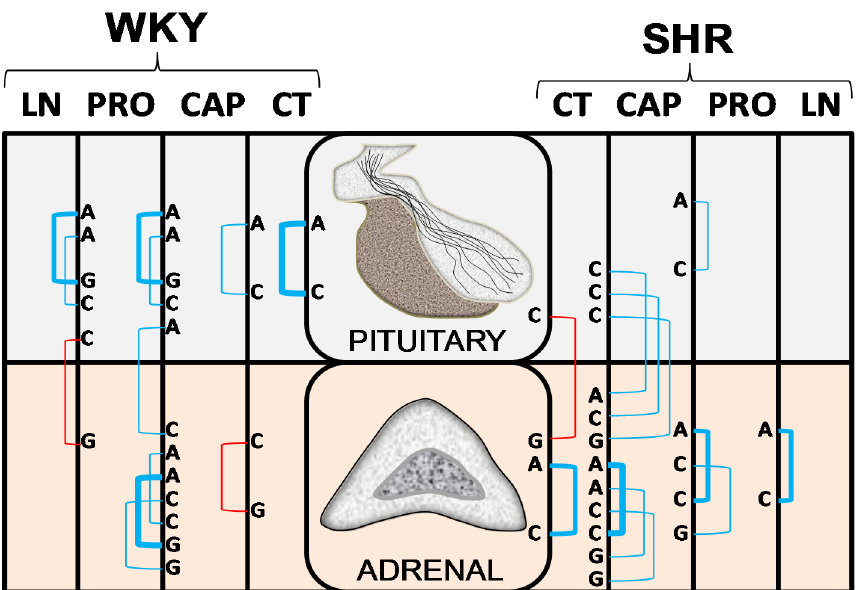
Figure 4. Significant intra- and inter-gland correlations between angiotensinase activities of pituitary and adrenal glands in non-treated Wistar–Kyoto (WKY) and spontaneously hypertensive rats (SHR) (control, CT) or treated with captopril (CAP), propranolol (PRO) or L-NAME (LN). Blue lines: positive significant correlations; red lines: negative correlations; line thickness: degree of significance (this representation corresponds to the values indicated in Table 1). Alanyl-aminopeptidase (A), cystinyl aminopeptidase (C) and glutamyl-aminopeptidase (G).